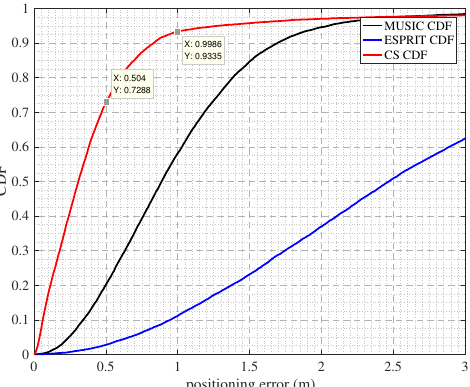
Figure 8. Cumulative distribution function of the positioning errors for the outdoor LOS test.